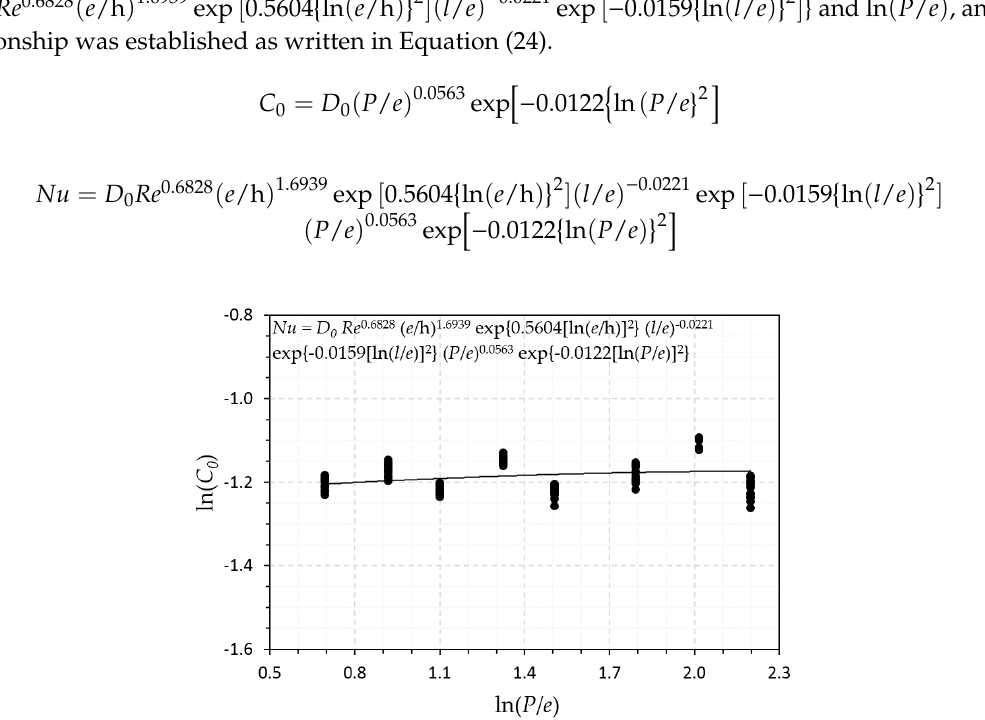
Figure 18. Plot of ln ( C 0 ) as function of ln ( P / e ).